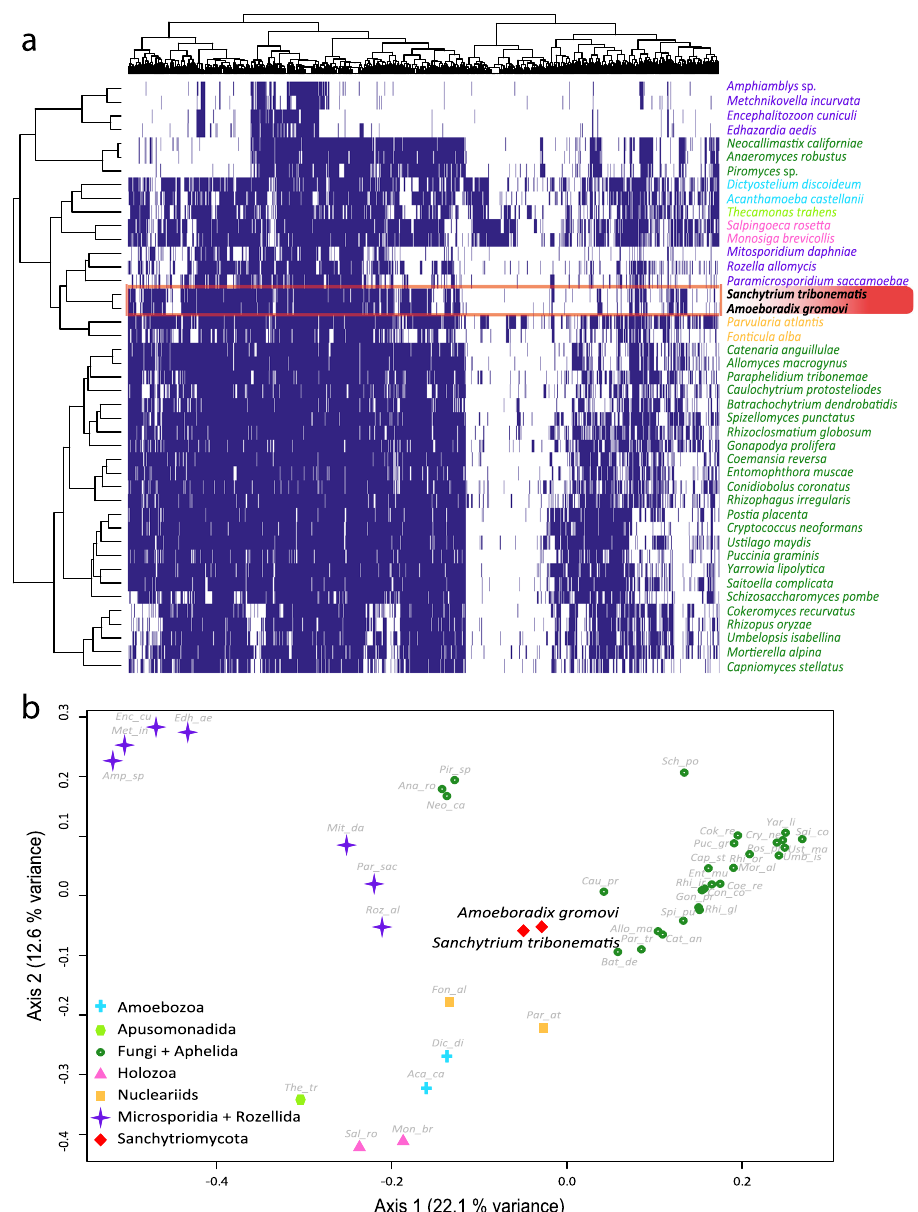
Fig. 3 Distribution patterns of primary metabolism genes in Holomycota. a Binary heatmap and b principal coordinate analysis (PCoA) species clustering based on the presence/absence of 1158 orthologous genes belonging to eight primary metabolism Gene Ontology categories across 43 eukaryotic genomes and transcriptomes. Species are colour- and shaped-coded according to their taxonomic af fi liation as indicated in the legend. COG presence is depicted in blue and absence is depicted in